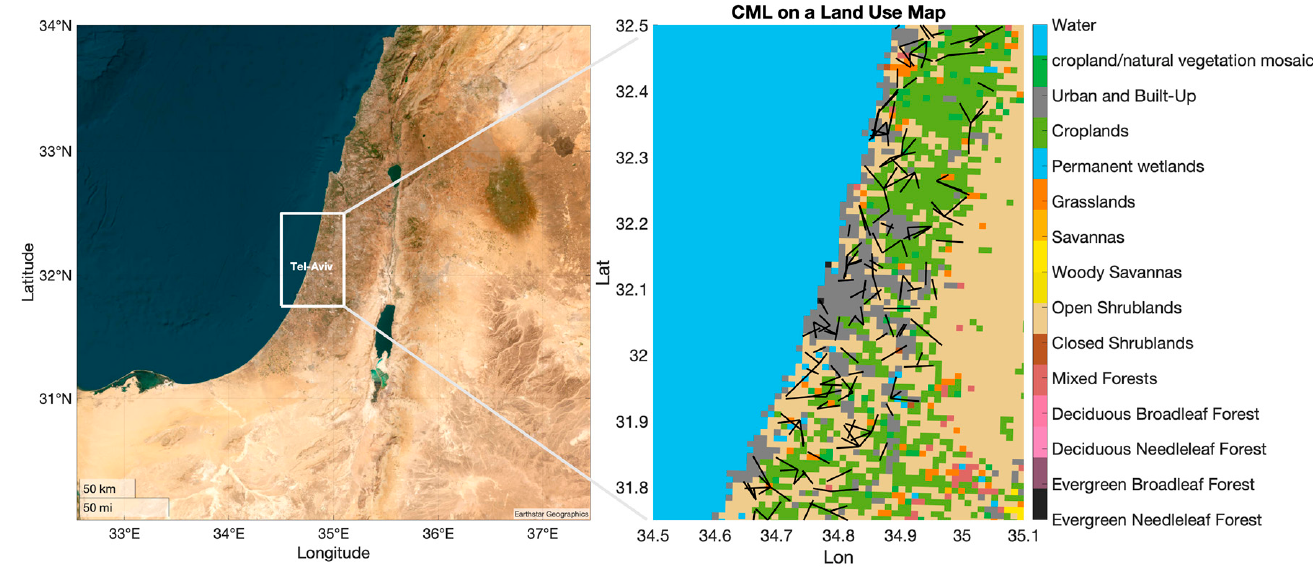
Figure 1. A map of 388 links with lengths between 2–10 km and frequencies of approximately 23 GHz on a land-use map. Land-use types are shown on the color bar to the right (https://www2.mmm. ucar.edu/wrf/users/download/get_sources_wps_geog.html, accessed on 23 October